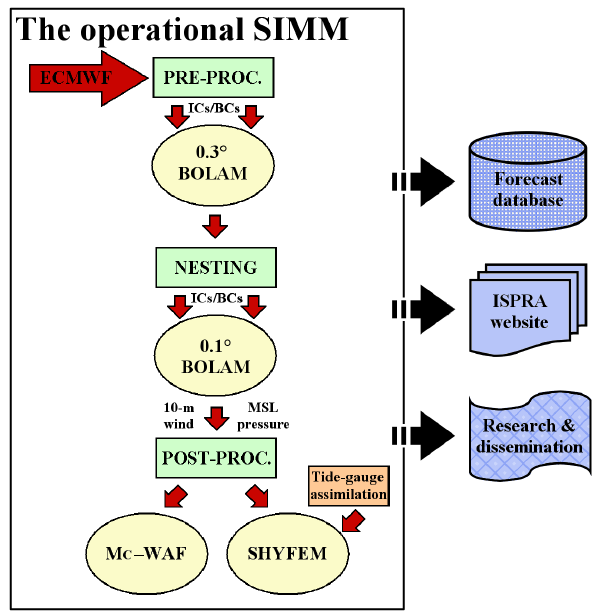
Figure 1. A sketch of the general processing scheme for the op- erational SIMM: from the ECMWF forcing to the storage, online publication and use for research and dissemination of weather, ma- rine and coastal products. The operational configuration includes the BOLAM meteorological model nested at 0.3 and 0.1 ◦ , with a 0.5 ◦ ECMWF forcing, the Mc-WAF wave modelling suite forced by the 0.1 ◦ BOLAM, and the low/high-resolution SHYFEM sea surge model forced by the 0.1 ◦ BOLAM (and ECMWF – not shown), with and without a tide-gauge assimilation process.